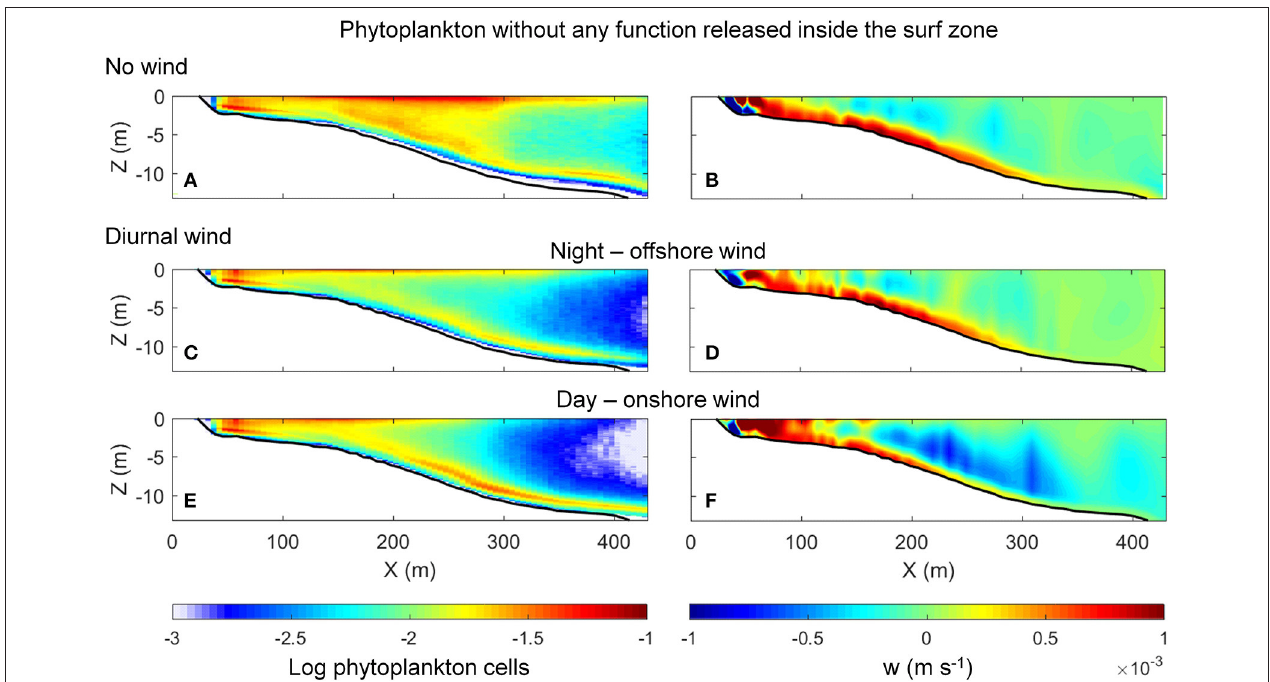
FIGURE 7 | (A,C,E) Alongshore- and time-averaged phytoplankton cells without growth, sinking, or DVM released inside the surf zone. (B,D,F) Alongshore- and time-averaged vertical velocities. (A,B) No-wind case. (C,D) Nighttime and (E,F) daytime of the diurnal wind cycle.